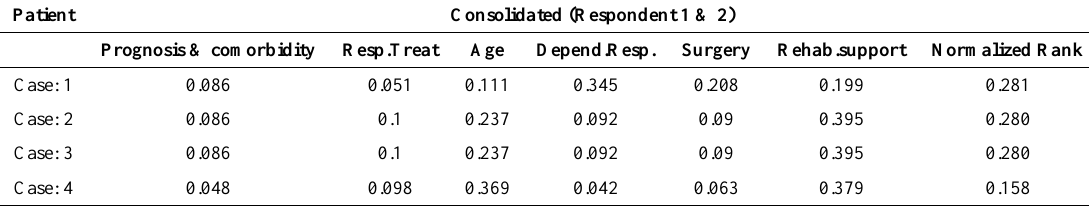
Table 15. Patient Rank with the Multi-Factor Triage Algorithm, (MUFTA) (Expert 1 and 2)